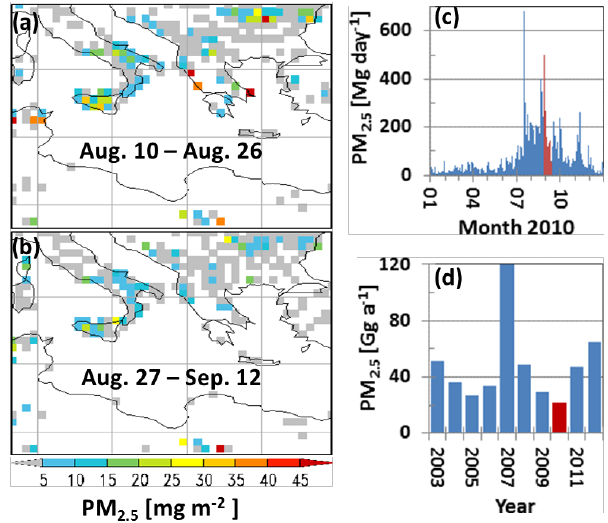
Figure 2. Spatial pattern of fire-related PM 2 . 5 emissions (Global Fire Assimilation System GFASv1.0; Kaiser et al., 2012) for the East Mediterranean (28–45 ◦ N/8–30 ◦ E), (a) time integral of 10–26 August, (b) time integral of 27 August–12 September 2010, given as sum over each period in mgm − 2 . Areas with no observed fire activity are displayed in white. Temporal pattern of domain- integrated (c) daily total PM 2 . 5 emissions over 2010 and (d) yearly total PM 2 . 5 emissions over 2003 to 2012. Labelled in red is (c) the period of the Urania cruise (27 August–11 September 2010) (d) and the year